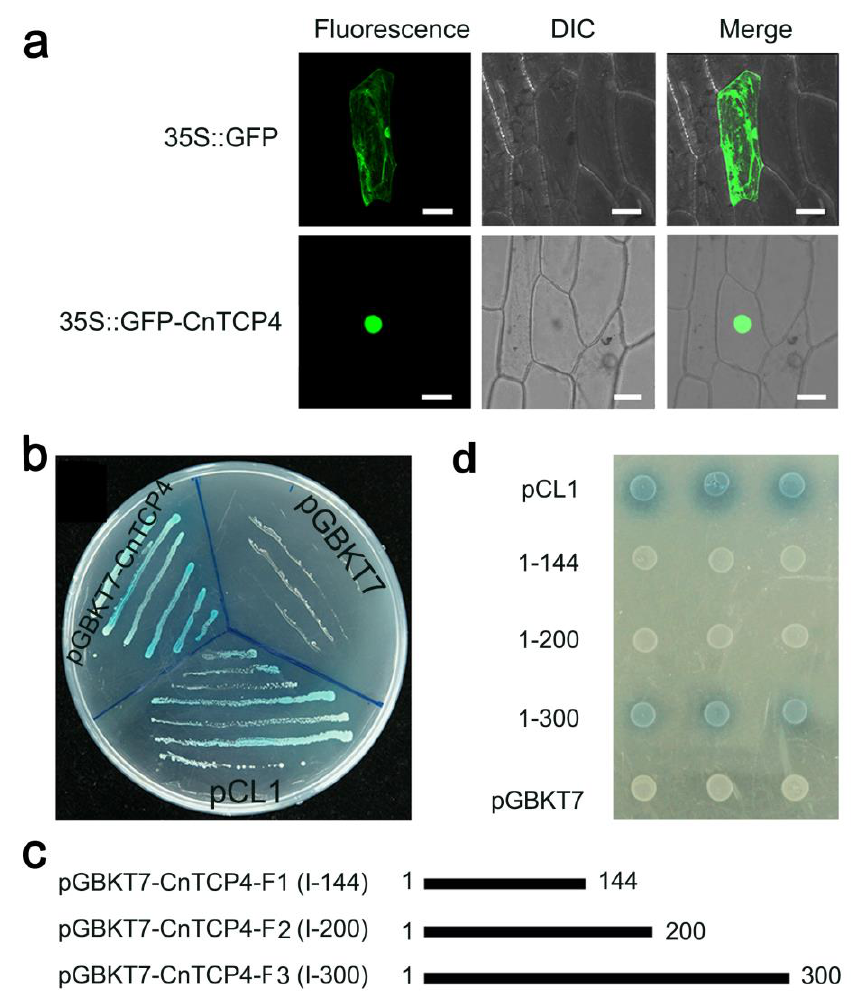
Figure 3. Subcellular localization of CnTCP4 in transgenic onion epidermal cells and the transcriptional activation activity of CnTCP4. ( a ) GFP activity generated by the p35S ::GFP-CnTCP4 transgene introduced into onion epidermis peels. Fluorescence: image recovered from the green fluorescence channel, DIC: image recovered under bright light, merged: an overlay of the fluorescence and DIC images. Bar: 50 μm. ( b ) a yeast one hybrid assay used to detect the transcriptional activation activity of CnTCP4. ( c ) fragment constructs of different C’-deletion of CnTCP4 amino acid. ( d ) transcriptional activation activity of different C’-deletion of CnTCP4 .